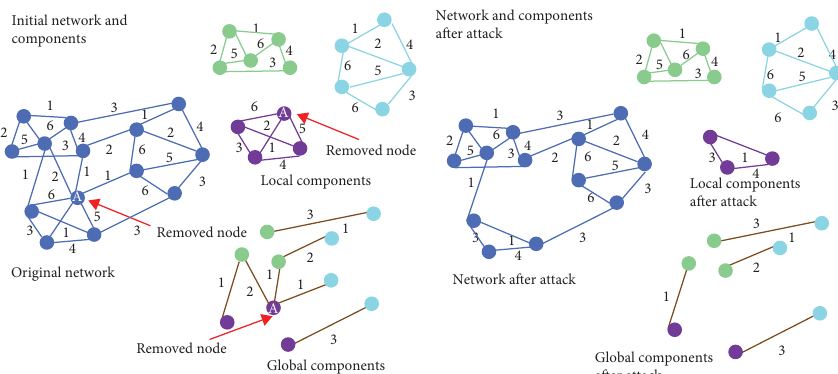
Figure 2: Tis toy example illustrates the infuence of an attack on the network component structure. Removing node A in the original network impacts the dark blue local component (one node and three links are removed). It also afects the largest global component, which splits into two components with two nodes and an isolated node. Indeed, A has a global and local role.